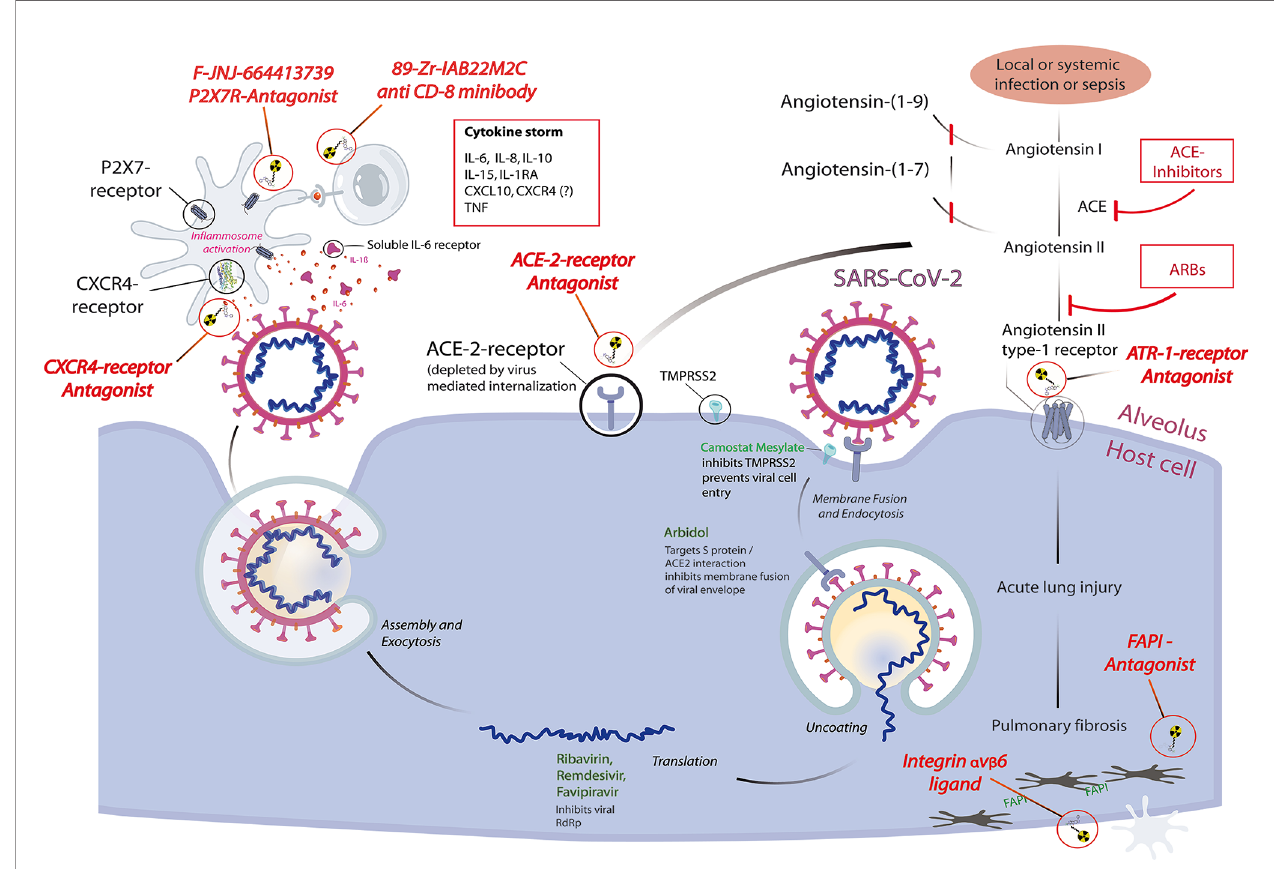
FIGURE 1 | Pictorial review highlighting selected molecular imaging targets for pathophysiological features of coronavirus disease 2019 (COVID-19) and their relation to current concepts of therapeutical interventions, based on a schematic representation of the reproduction cycle of SARS-CoV-2 at the alveolus – host cell interface. Radiopharmaceuticals (red italic) are depicted at their speci fi c binding sites: receptor antagonists binding to their respective receptors, integrin ligands and FAPI- antagonists schematically binding to their respective target structures. Intracellular therapeutic interventions (green) and systemic interventions (red) are shown for their possible downstream effects that will in fl uence the dependent functional imaging principle. Each diagnostic receptor binding site also represents a possible therapeutic target site, thus any therapeutic use of receptor antagonists intrinsically forms a displacement challenge for its diagnostic twin, allowing a direct quantitation of localized therapeutic receptor